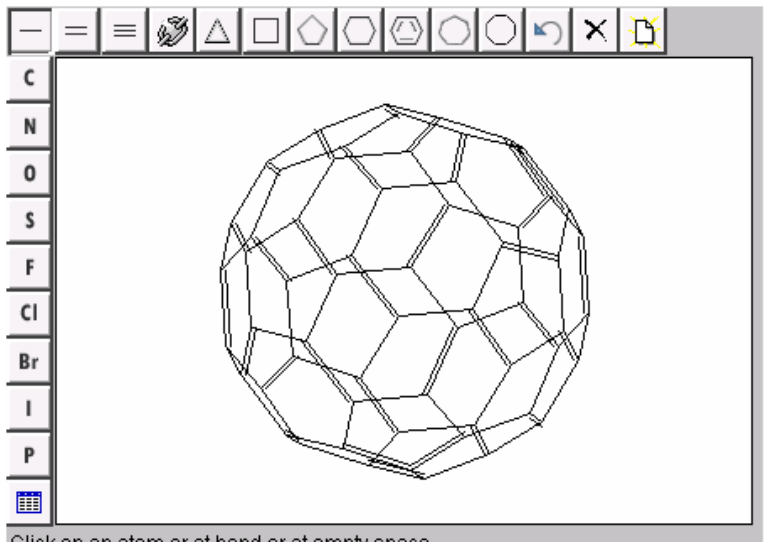
Figure 6. Computer-generated drawing of [60] fullerene molecule in the MCDL applet